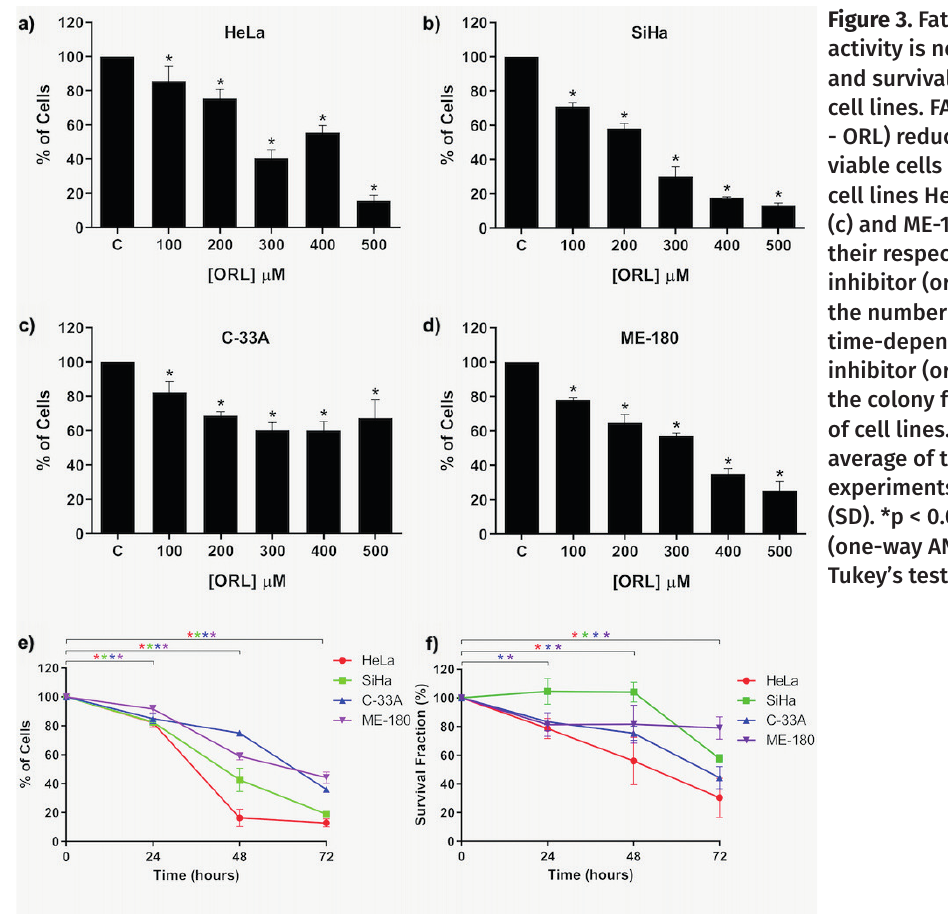
Figure 3. Fatty acid synthase (FASN) activity is necessary for the growth and survival of cervical cancer cell lines. FASN inhibitor (orlistat - ORL) reduced the number of viable cells in all cervical cancer cell lines HeLa (a), SiHa (b), C-33A (c) and ME-180 (d) compared to their respective controls. (e) FASN inhibitor (orlistat - ORL) reduced the number of viable cells in a time-dependent manner. (f) FASN inhibitor (orlistat - ORL) affected the colony formation capability of cell lines. Values refer to the average of three independent experiments ± standard deviation (SD). *p < 0.05 compared to control (one-way ANOVA followed by Tukey’s